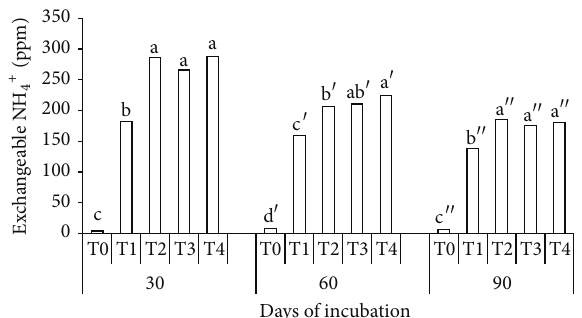
Figure 3: Effects of treatments (T0, T1, T2, T3, and T4) and periods (30,60,and90days)ofincubationonsoilexchangeableammonium.